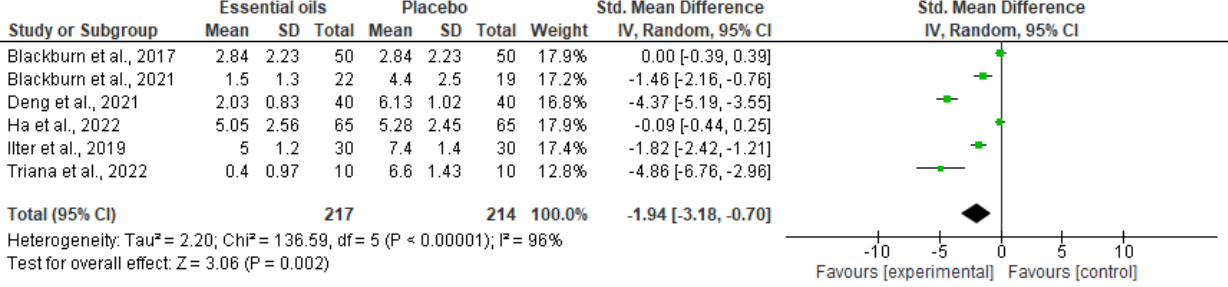
Figure 3. Forest plot of the meta-analysis for which six out of 12 retrieved studies are eligible. Essential oils represent the intervention, alone or in combination with other treatments, and placebo represents the control or the most inert comparator included in the studies with more than one comparator [71 – 74,76,82].